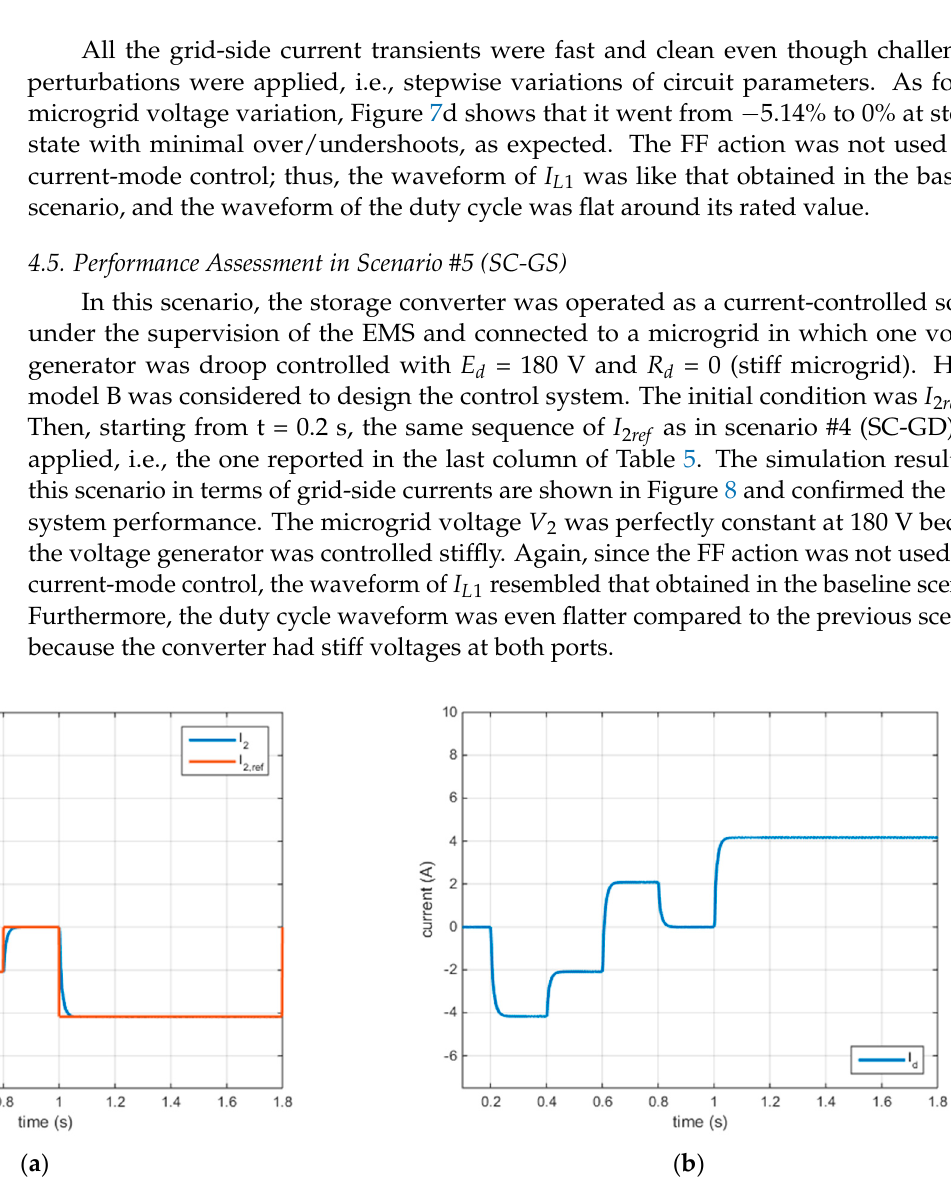
Figure 8. Performance obtained in scenario #5 (SC − GS): ( a ) actual and reference output current; ( b ) droop-controlled generator’s current.